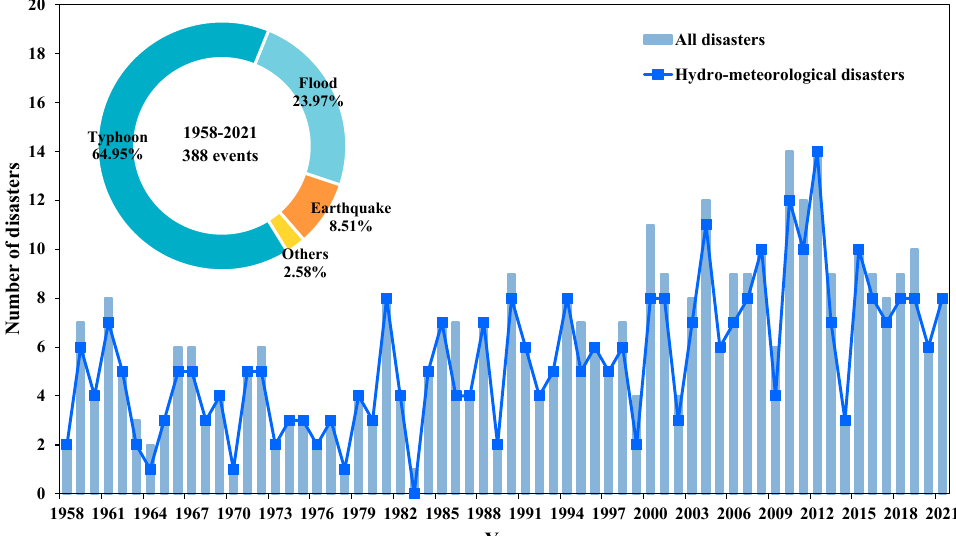
Figure 1. Number and types of natural disasters in Taiwan (1958–2021).